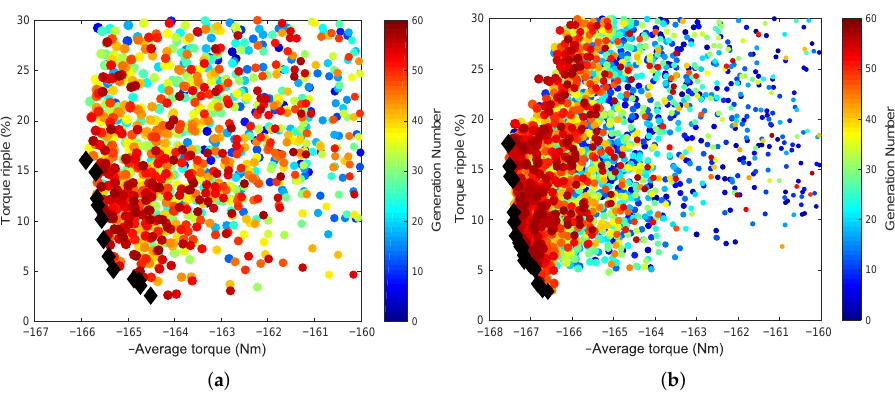
Figure 4. Optimization results for SynRM solutions with three barriers and four barriers per pole, respectively: ( a ) Three barriers per pole rotor; ( b ) Four barriers per pole